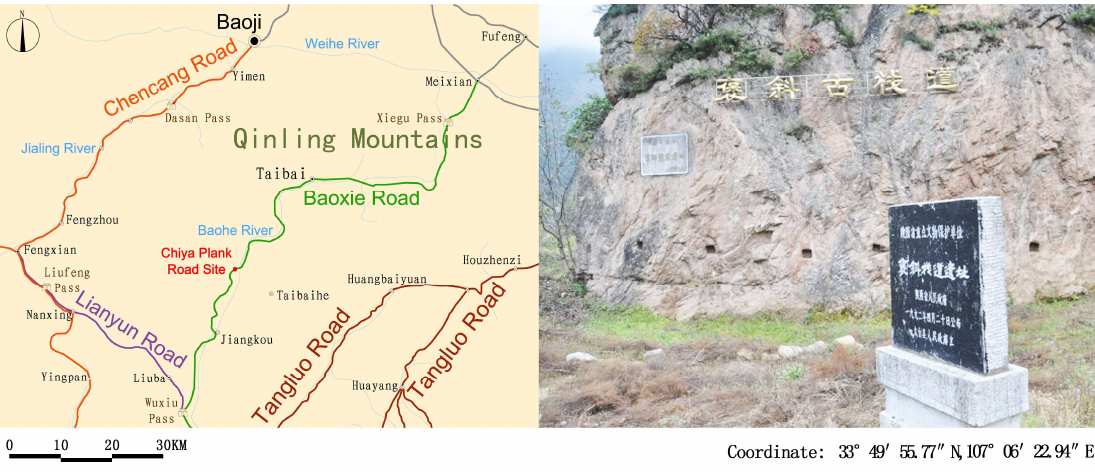
Figure 1. Chiya Plank Road Site.